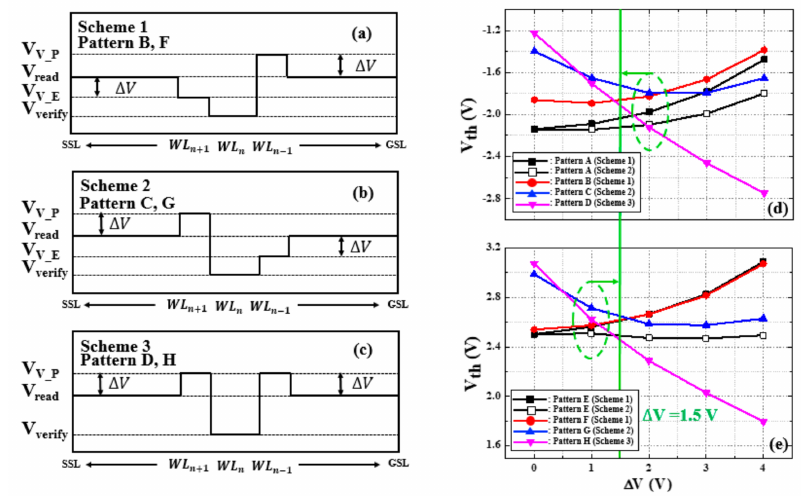
Figure 7. ( a , b , c ) Proposed bias condition when read operation according to the pattern. ( d , e ) The V th value according to ∆ V of each pattern for optimization of the proposed scheme.